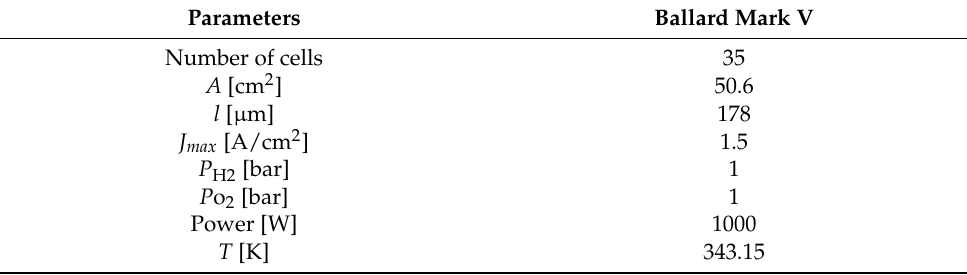
Table 3. Technical specification and operating condition of PEMFC.